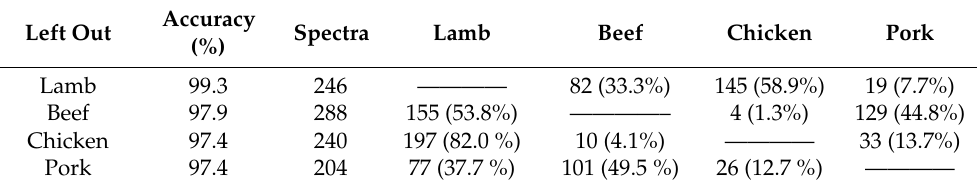
Table 7. SVM classification performance in leave-class-out validation. Accuracy values (column 2) are based on Venetian blinds (number of data split: 10, thickness: 1) cross-validation of the remaining three class data (ground meat samples) for the NIR